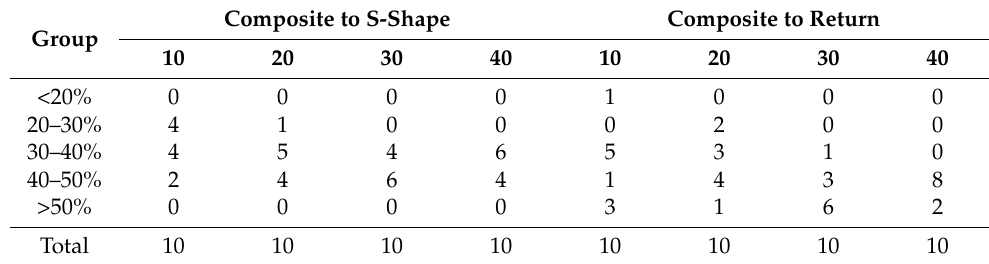
Table 11. Summary of optimization